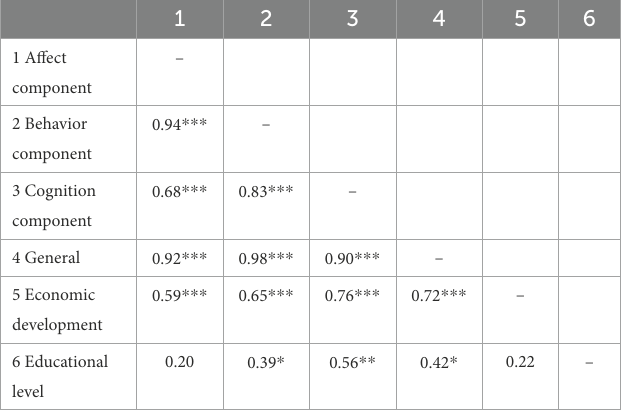
TABLE 3 Correlation matrix of dependent variables and provincial-level independent